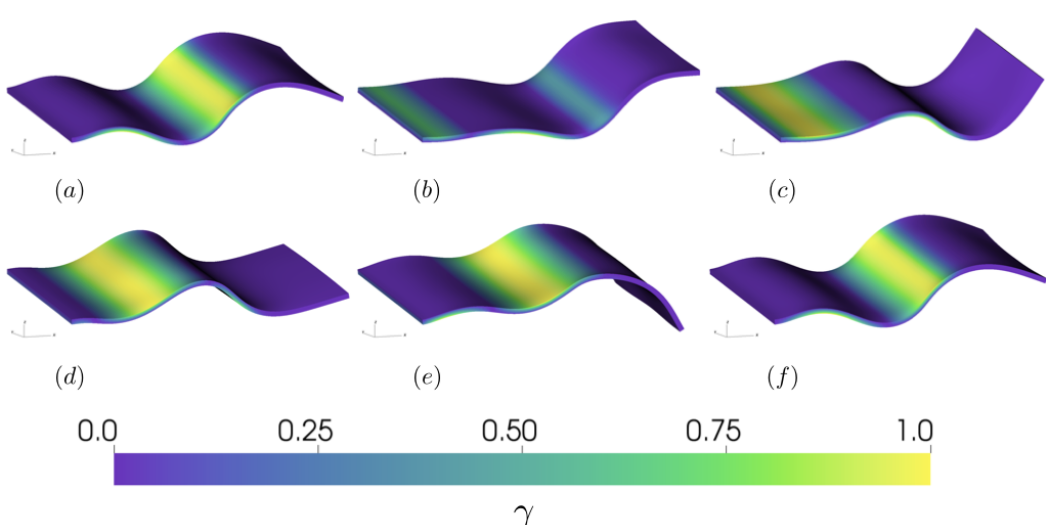
Figure 2. Snapshots of the tail during a steady-state activation cycle of the active stress at times ( a ) 9.0, ( b ) 9.2, ( c ) 9.4, ( d ) 9.6, ( e ) 9.8, and ( f ) 10.0. Tail color indicates the instantaneous strength of contraction, γ , with 1 representing peak applied tension and 0 representing no applied tension. Note that the activation wave is alternating between the two sides of the tail, with the top half fully out of phase with the bottom